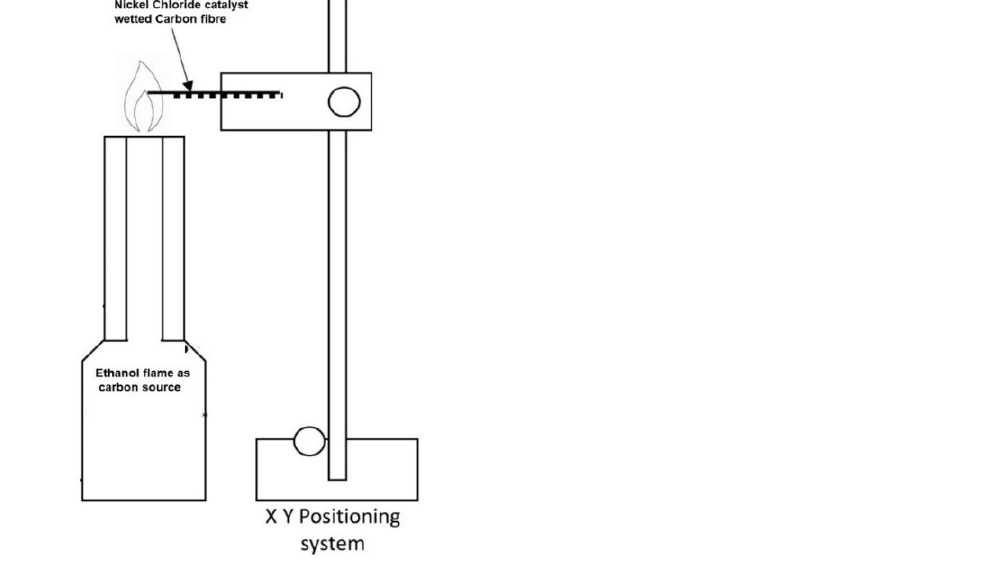
Figure 10. Experimental set-up to grow CNTs on carbon fibres through flame synthesis process (reprinted with permission) [59].